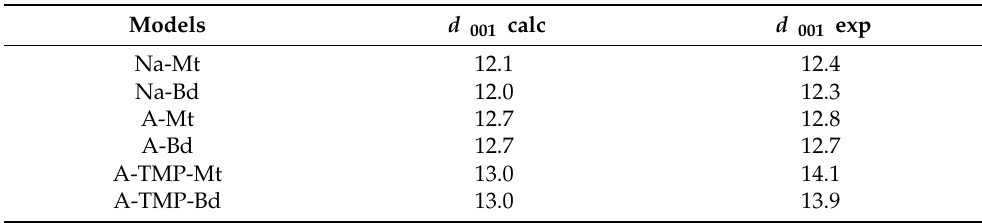
Table 1. Calculated ( d 001 calc) and experimental ( d 001 exp) values (Å) for Na-Mt, Na-Bd, A-Mt, A-Bd, A-TMP-Mt and A-TMP-Bd